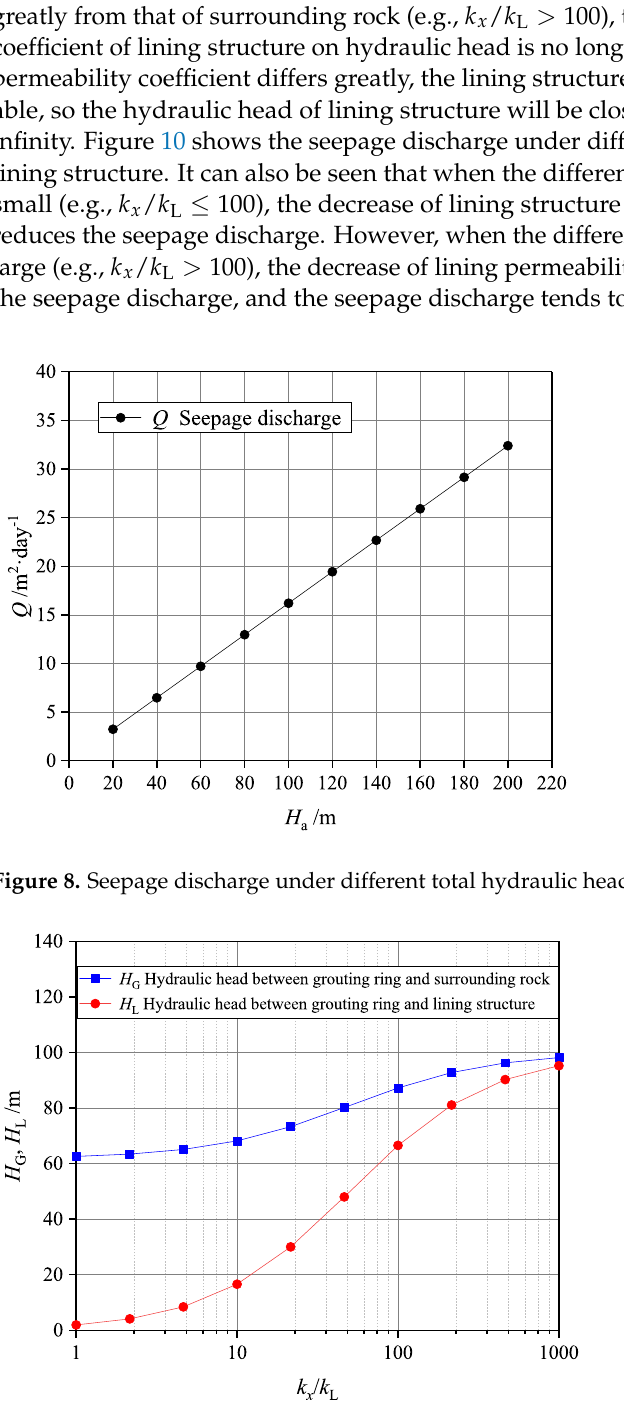
Figure 9. Hydraulic head of grouting ring and lining structure under different permeability coefficient of lining